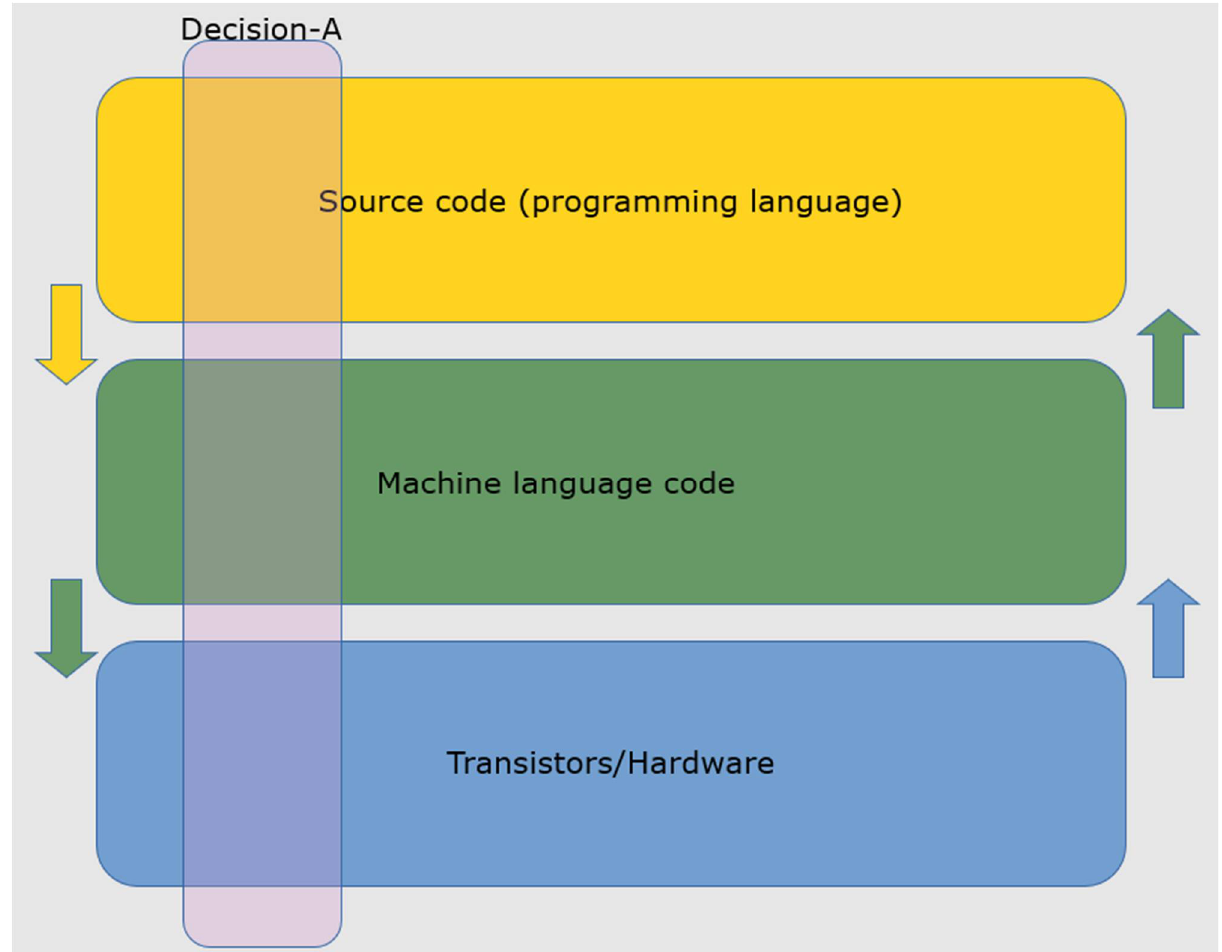
Figure 3. The decision stack for a non-intelligent digital machine. Source code for a computer program is written in a programming language (e.g., Python). The source code describes an algorithm to operate on structured data to produce a decision. For all intents and purposes, the program is deterministic. An interpreter or a compiler translates the source code into machine language, which then instructs the hardware layer to turn on and off electronic components (transistors) to produce